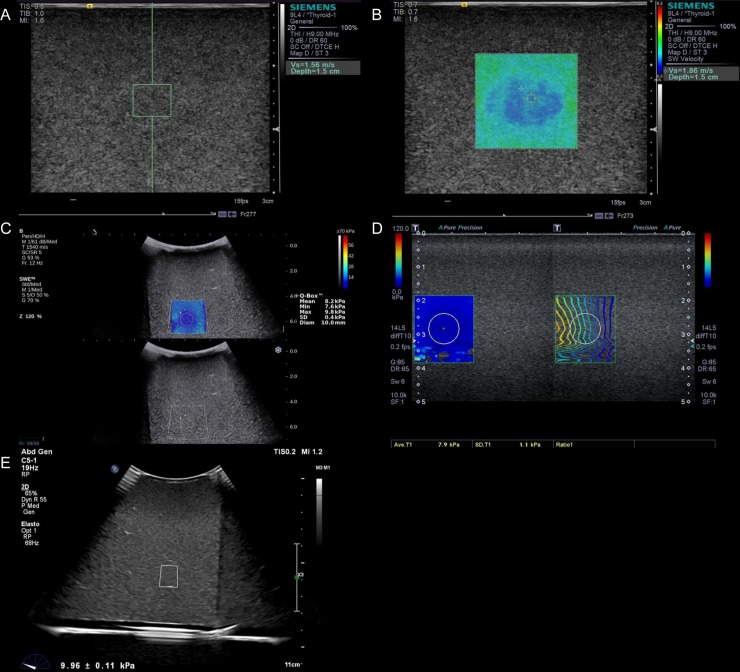
Measurements of shear wave elasticities in a target of 8 ± 3 kPa using four different machines.(A and B) A linear transducer and the VTQ system and a linear transducer and the VTIQ system (ACUSON S2000, Siemens Healthcare, Erlangen, Germany) at depths of 15 mm, (C) a curved transducer and the Aixplorer system (Supersonic Imagine, Aix Provence, France) at a depth of 60 mm, (D) a linear transducer and the Aplio 500 system (Toshiba Medical Systems, Tochigi-ken, Japan) at a depth of 30 mm, and (E) a curved transducer and the EPIQ 5 system (Philips Medical System, Best, the Netherlands) at a depth of 60 mm.